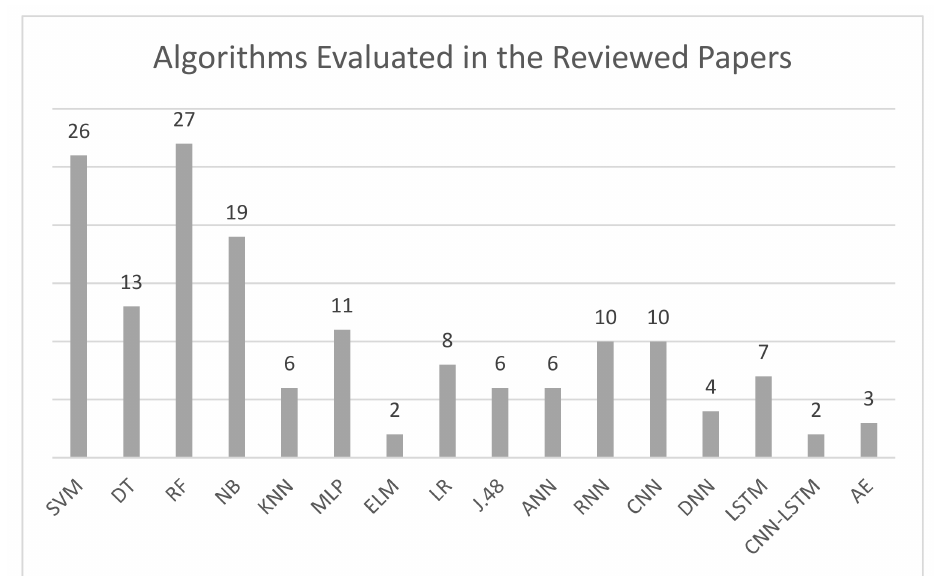
Figure 1. ML and DL algorithms used in the reviewed